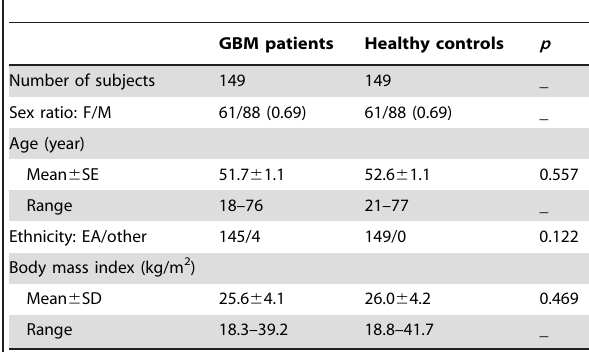
Table 1. Characteristics of glioblastoma multiforme (GBM) patients and healthy control subjects selected from the Upper Midwest Health